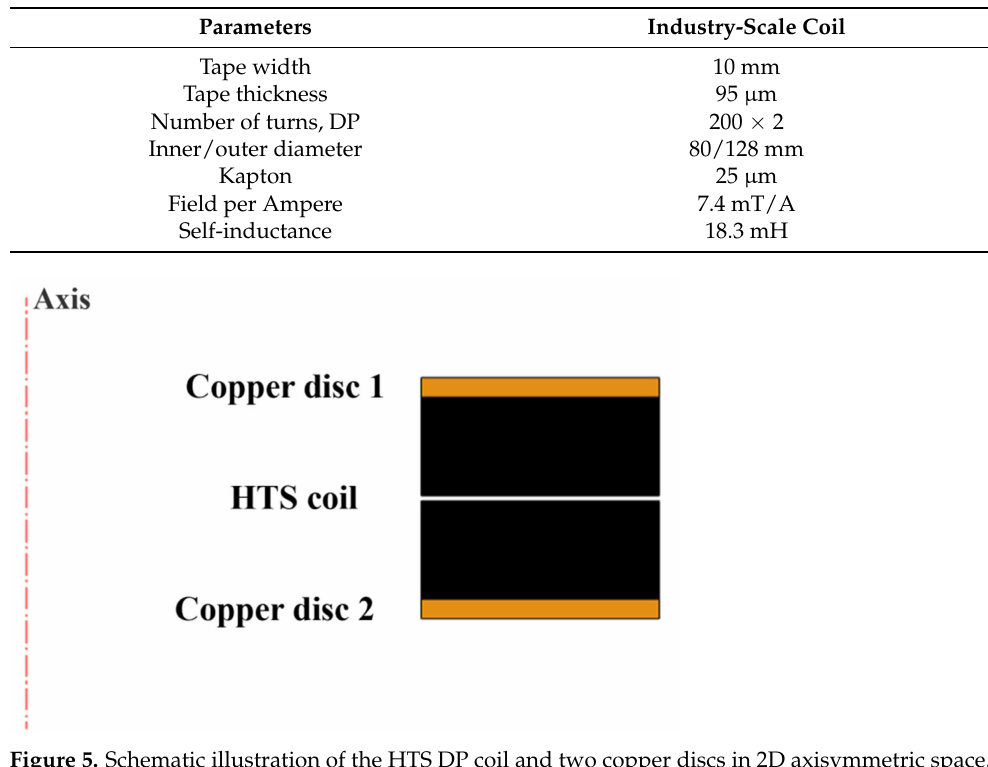
Table 2. Specifications of the large-scale coil.